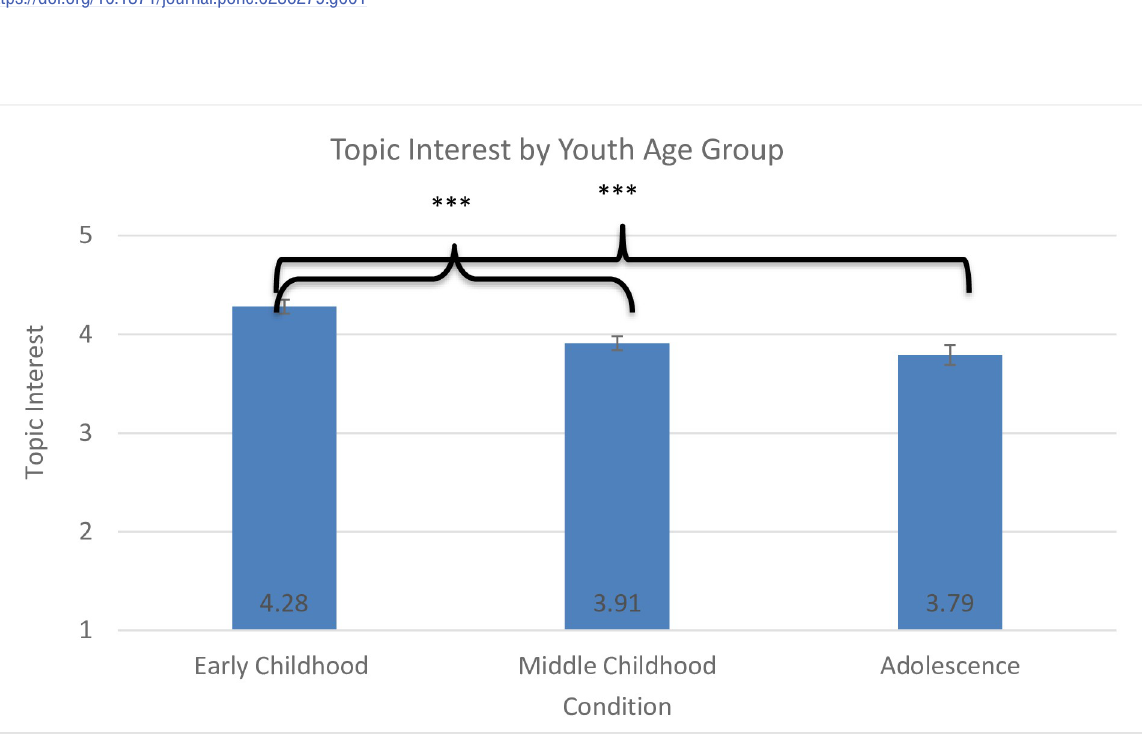
PLOS ONE | https://doi.org/10.1371/journal.pone.0236279 July 23,